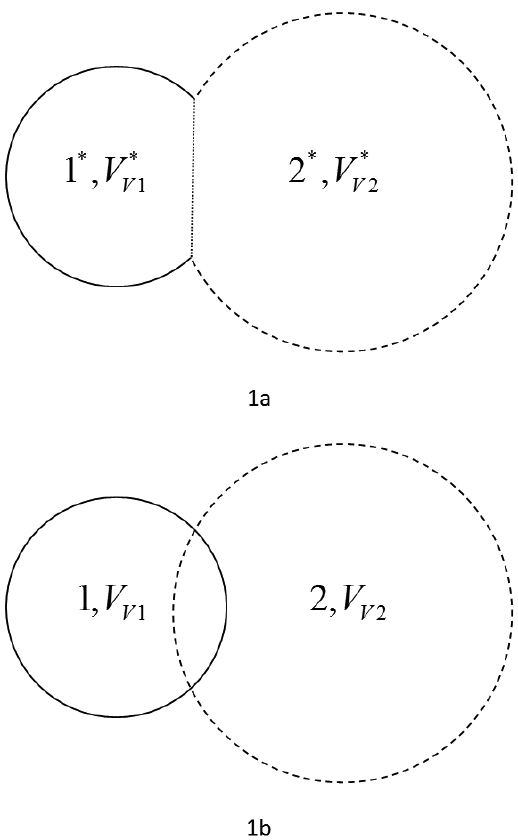
Figure 1. Illustration of the definitions of experimental (1a) and theoretical (1b) quantities for two transformations; (1a) The “visible” or “experimental” transformed region of each reaction is indicated by 1 ∗ and 2 ∗ . The volume fraction of 1 ∗ and 2 ∗ are ∗ , are called “experimental ∗ and ∗ and ∗ , respectively. 2 V V 1 V V 1 V V 2 V V volume fractions”. The dotted line on the right hand side figure is the boundary between 1 ∗ and 2 ∗ ; (1b) The “theoretical” transformed region of each reaction is labeled 1 and 2. The volume fractions of 1 and 2 are V and V , respectively. V and V are called V 1 V 2 V 1 V 2 “theoretical volume